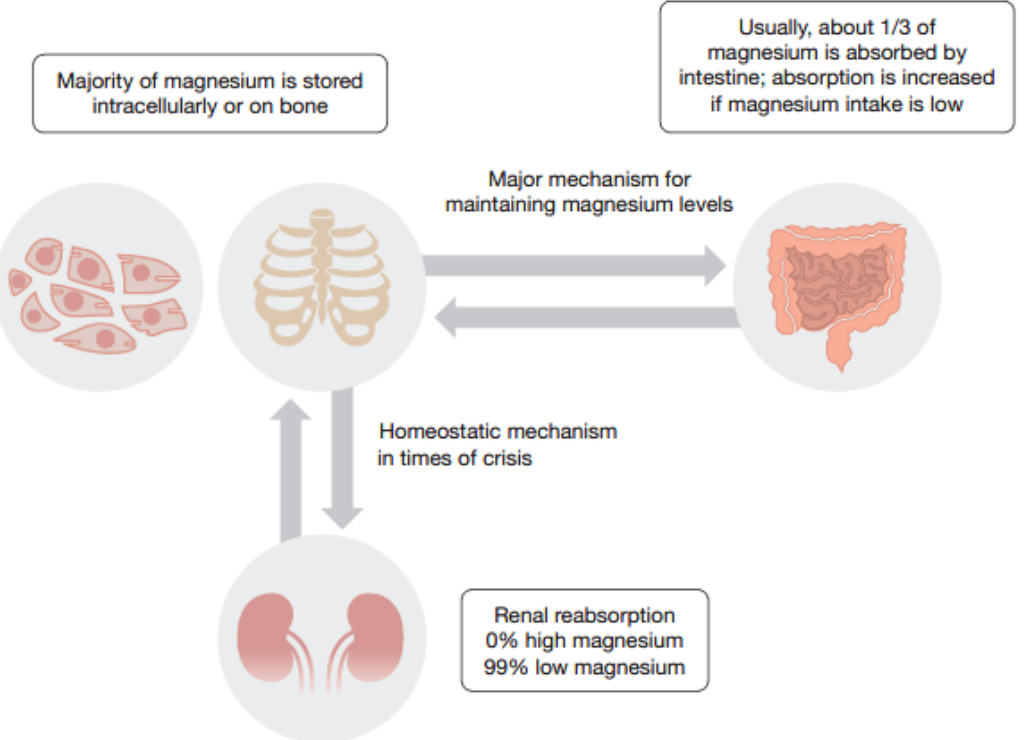
Figure 1. Schematic presentation of magnesium homeostasis.